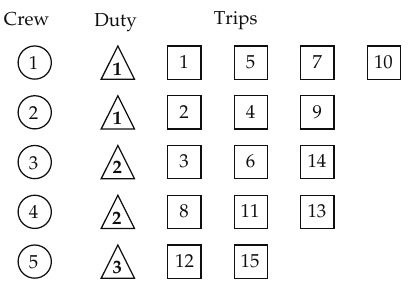
Figure 2: The expression of solution.